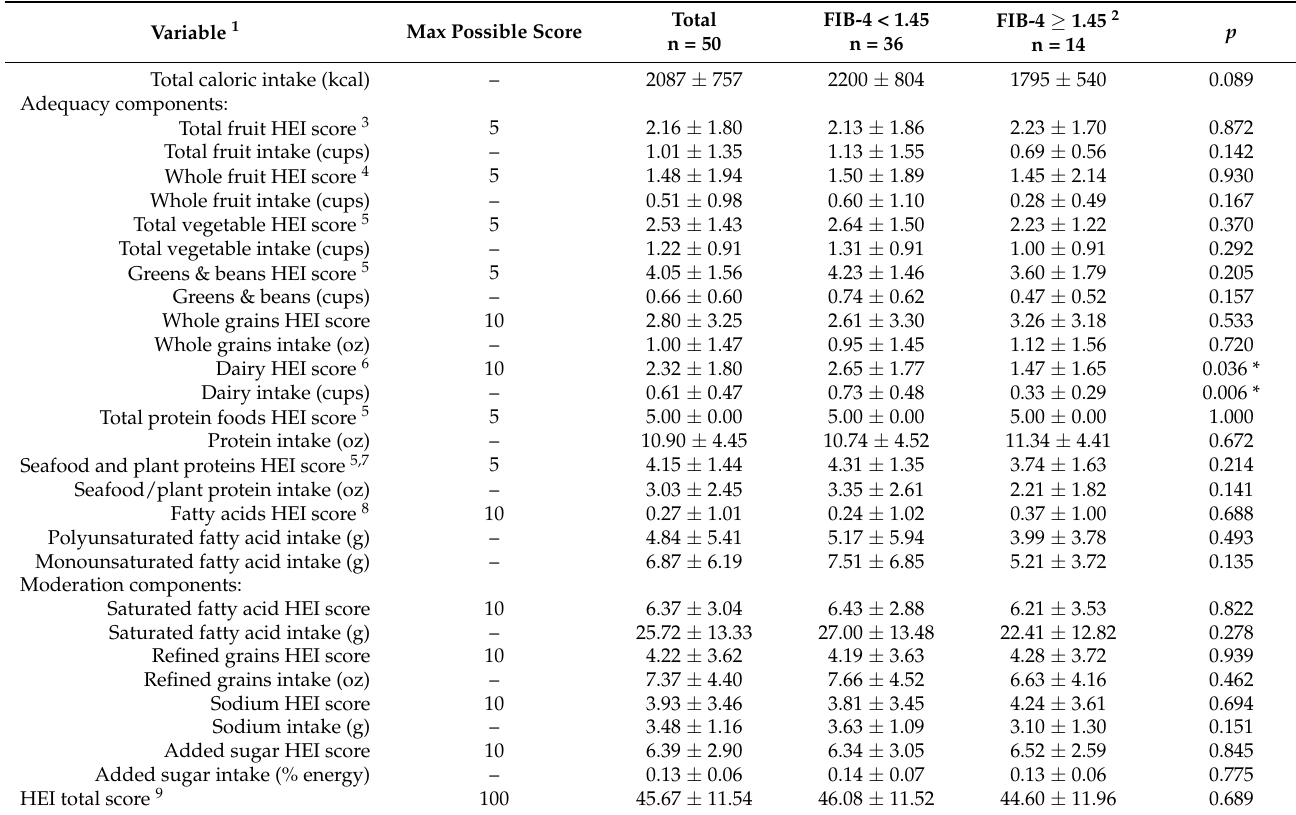
Table 2. Dietary intake and HEI scores of study participants by FIB-4